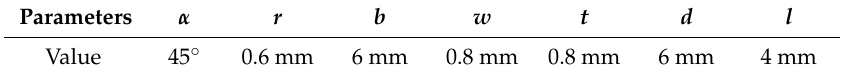
Table 1. Key parameters of bridge-type flexure hinge and the compound parallelogram flexure hinge.